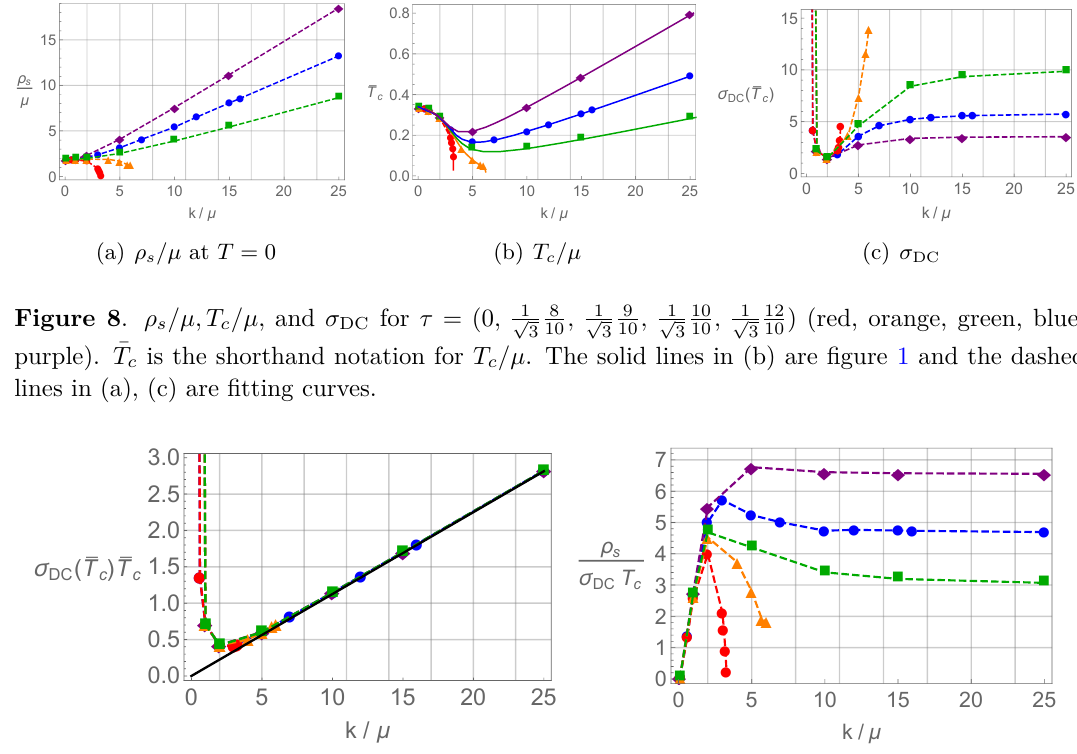
Figure 9 . Left: σ DC T c vs k . The black solid line is (3.13). Right: checking Homes’ law with τ = (0 , 1 √